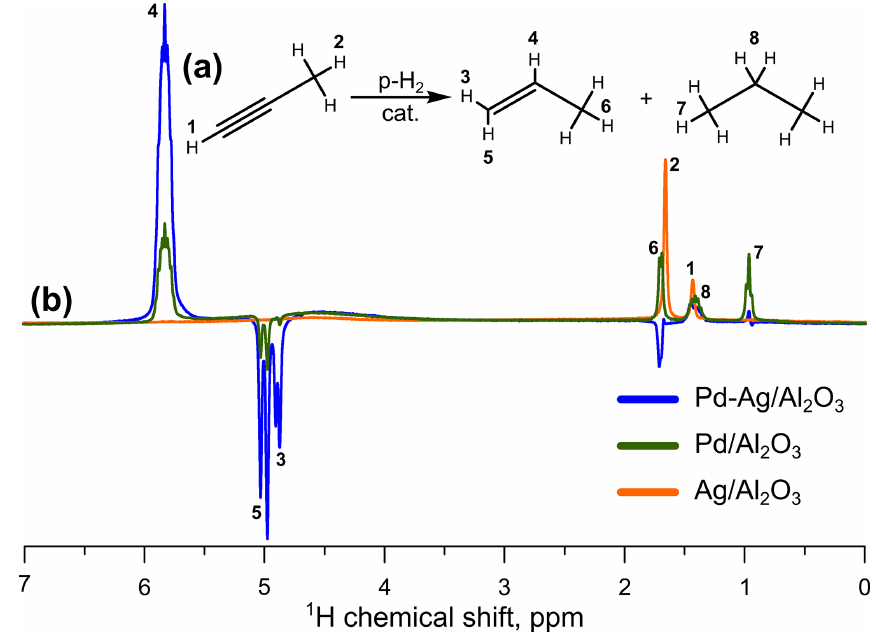
Figure 1. (a) Reaction scheme of propyne hydrogenation; (b) 1 H NMR ALTADENA spectra acquired during propyne hydrogenation with parahydrogen over the Pd-Ag / Al 2 O 3 (blue line), Pd / Al 2 O 3 (green line), or Ag / Al 2 O 3 catalyst (orange line). The reaction temperature was 200 ◦ C, and the total gas flow rate was 3.8mLs − 1 . All spectra were acquired with eight signal accumulations and are presented on the same vertical scale.